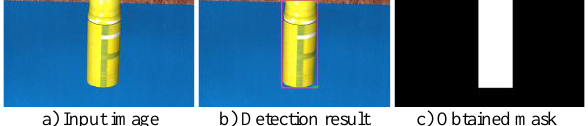
Figure 14. Developed CNN-based segmentation process.